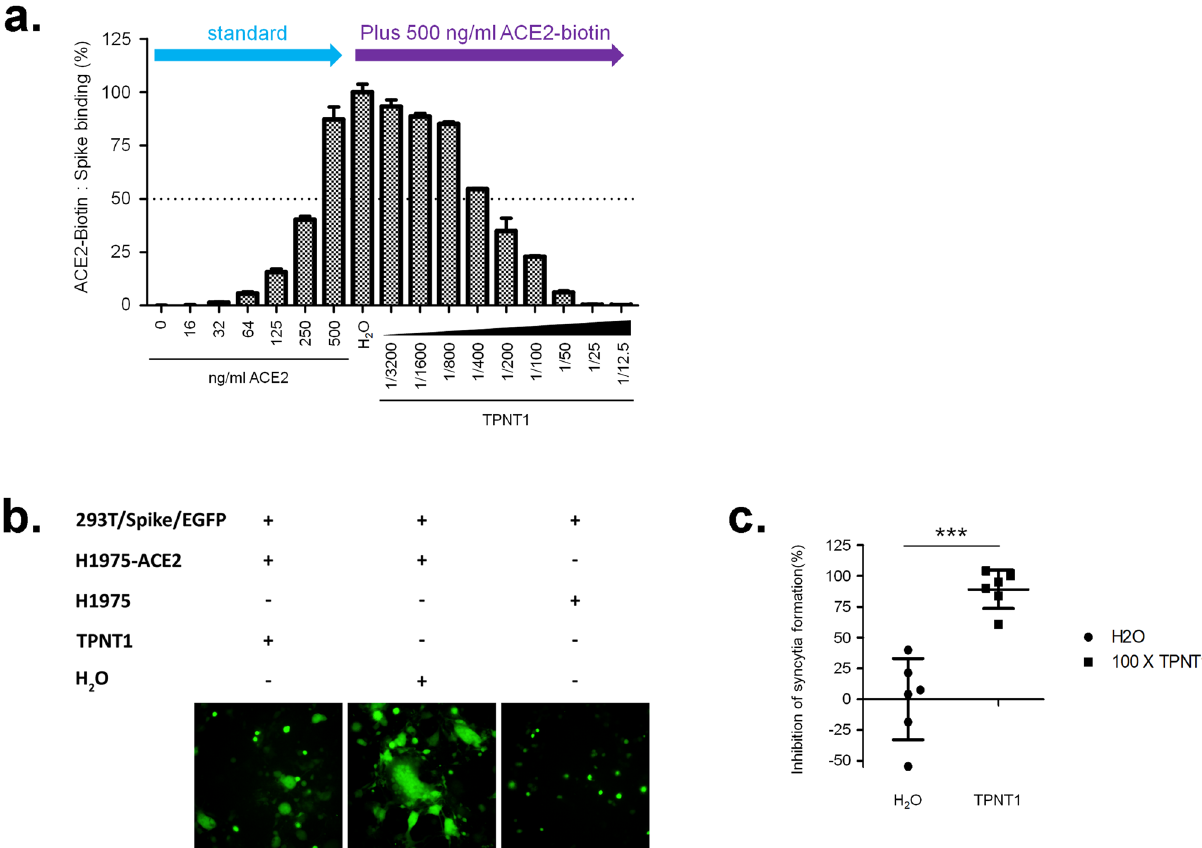
Figure 4. Inhibition of SARS-CoV-2 entry by TPNT1. ( a ) TPNT1 blocks binding of spike proteins to ACE2-Fc- Biotin; ( b & c ) TPNT1 inhibited syncytium formation between 293 T/Spike/EGFP and H1975-ACE2 cells. At least three independent experiments were performed and one representative result was shown. P <